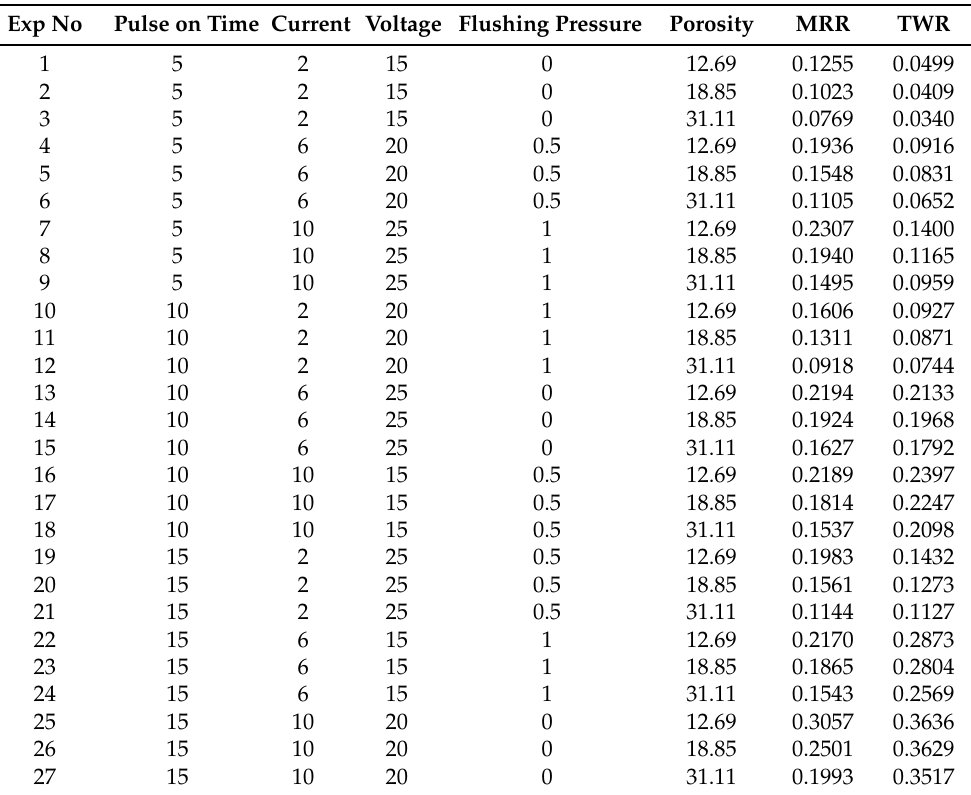
Table 4. Experimetal layout using an L 27 Orthogonal